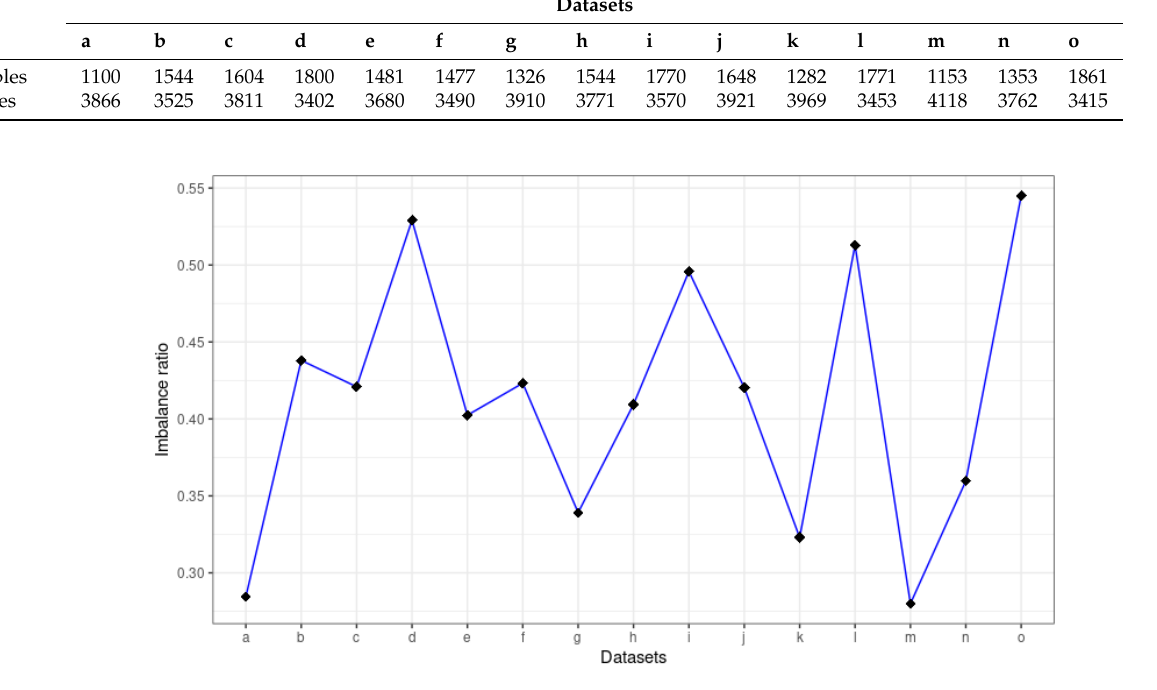
Figure 1. A plot illustrating imbalance ratio for each dataset in the power grid datasets. With the exception of dataset a, g, k, m, and n, all other datasets exhibit a less severe imbalance (e.g., IR > 0.4 in our